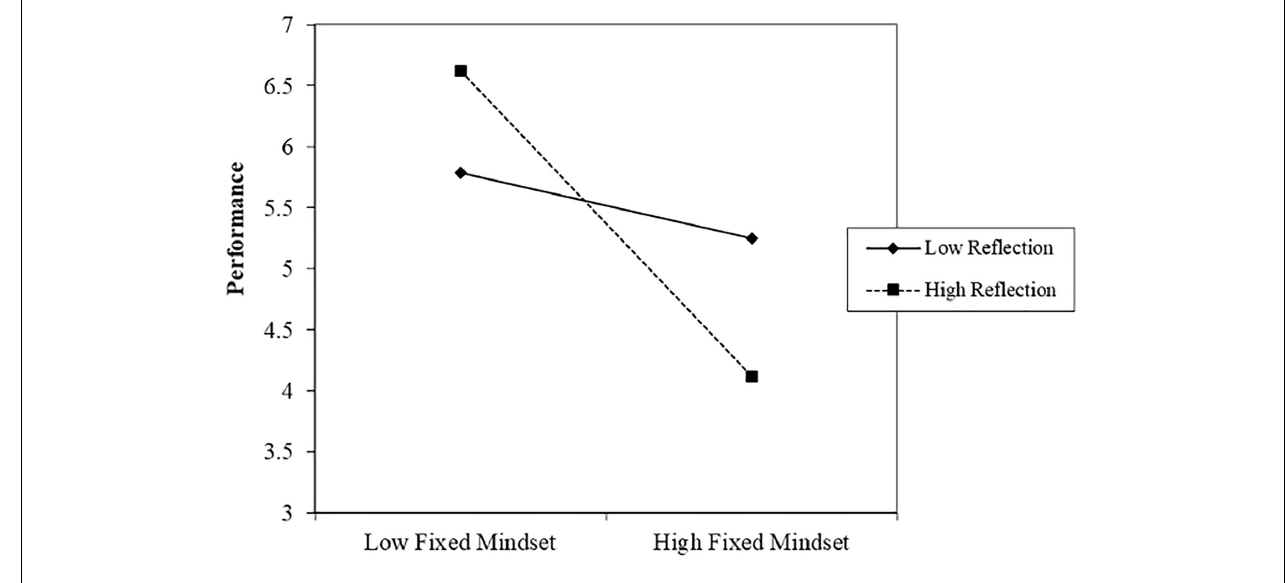
FIGURE 3 | Self-reflection on fixed mindset and performance.